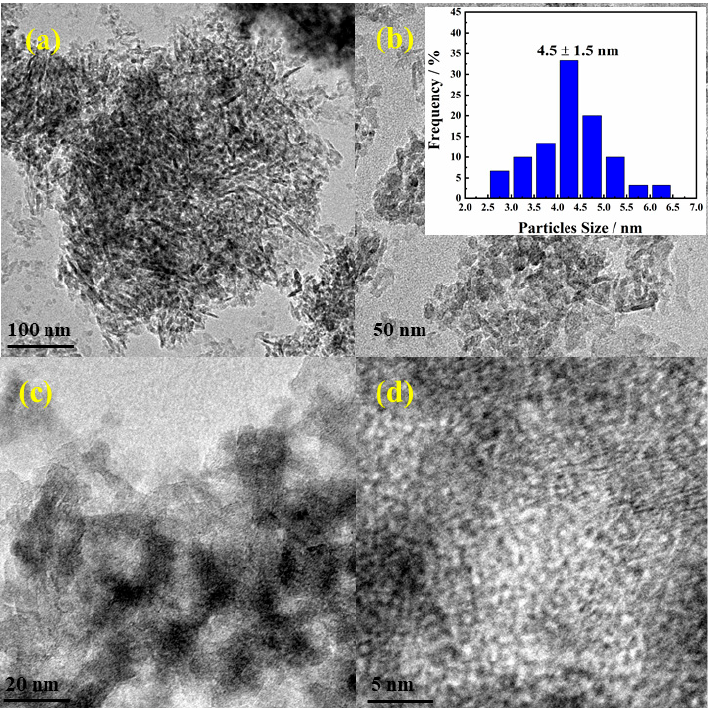
Figure 6. TEM and HRTEM images of TI-NiO/ γ -Al 2 O 3 catalyst, ( a – d ) are images under the different scales.